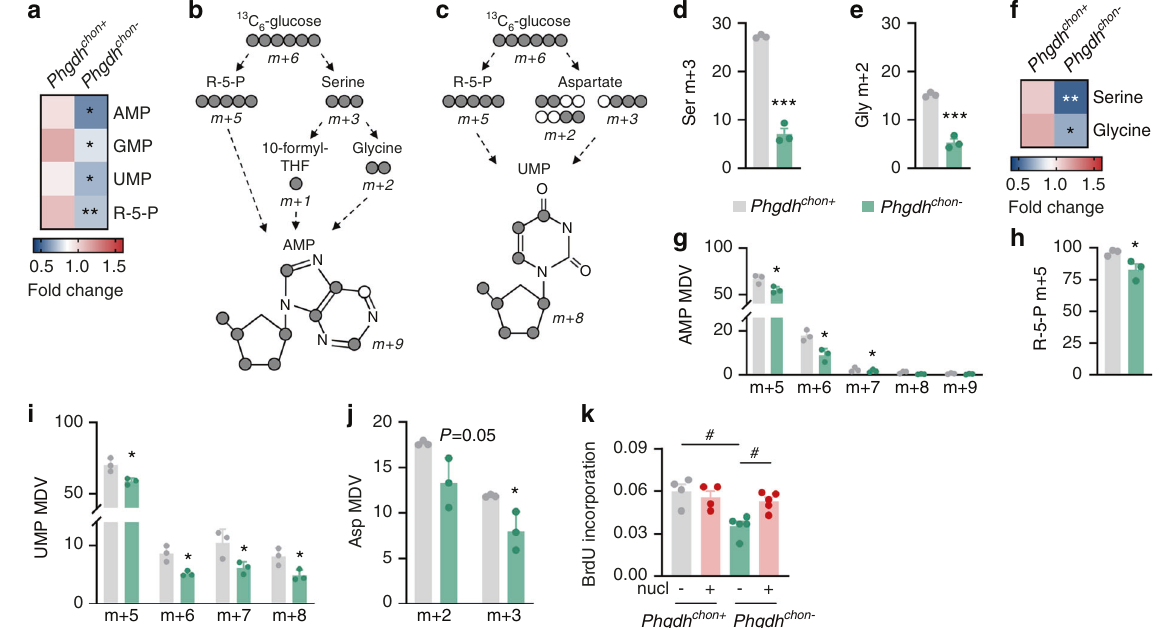
Fig. 3 PHGDH regulates nucleotide synthesis in chondrocytes. a Purine (AMP, GMP), pyrimidine (UMP) and ribose-5-phosphate (R-5-P) levels in cultured chondrocytes derived from wild-type ( Phgdh chon + ) and chondrocyte-speci fi c PHGDH knockout ( Phgdh chon- ) mice ( n = 3). Schematic of carbon atom (circles) transitions of 13 C 6 -glucose used to detect label incorporation into AMP ( b ) and UMP ( c ). Serine (Ser; d ) and glycine (Gly; e ) labeling from 13 C 6 -glucose in cultured chondrocytes ( n = 3). Speci fi c mass distribution vectors (MDVs) for each metabolite are shown. f Intracellular Ser and Gly levels in cultured chondrocytes ( n = 3). AMP ( g ), ribose-5-phosphate (R-5-P; h ), UMP ( i ) and aspartate (Asp; j ) labeling from 13 C 6 -glucose in cultured chondrocytes ( n = 3). Speci fi c MDVs for each metabolite are shown. k Proliferation of cultured chondrocytes with or without nucleotide (nucl) supplementation ( n = 4 – 5), as determined by BrdU incorporation. The data are presented as the means